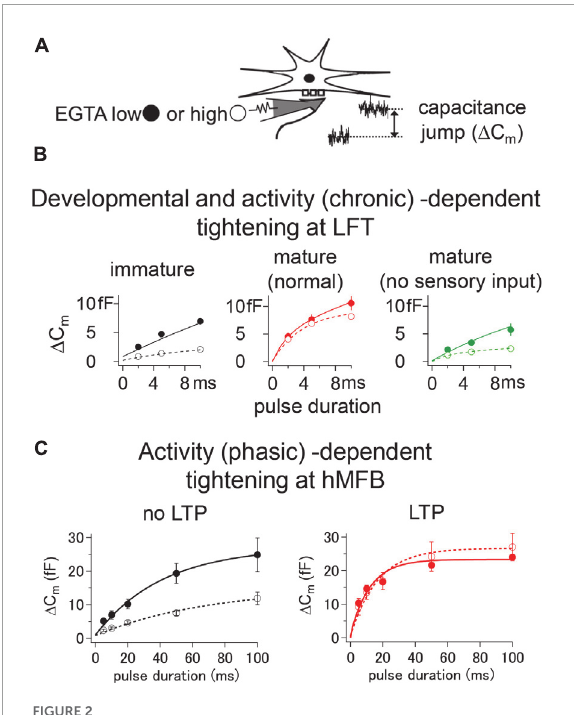
Midorikawa and Miyata, 2021). At the calyx of Held, it is